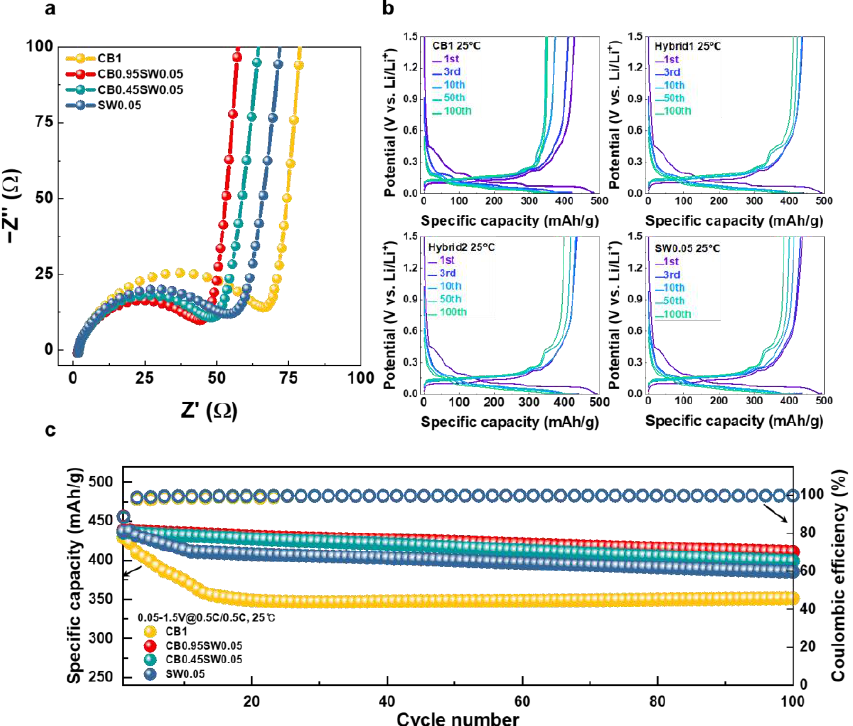
Figure 3. Characterization of electrochemical properties of half cells: ( a ) impedance measurement (EIS); ( b ) charge/Discharge curves in the 1st, 2nd, 3rd, 10th, 50th, and 100th cycles; and ( c ) cycle performance during 100 cycles.